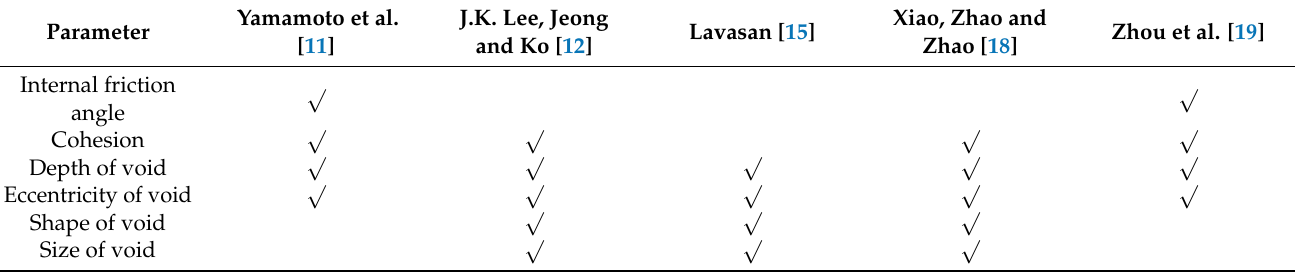
Table 1. Parameters investigated in recent